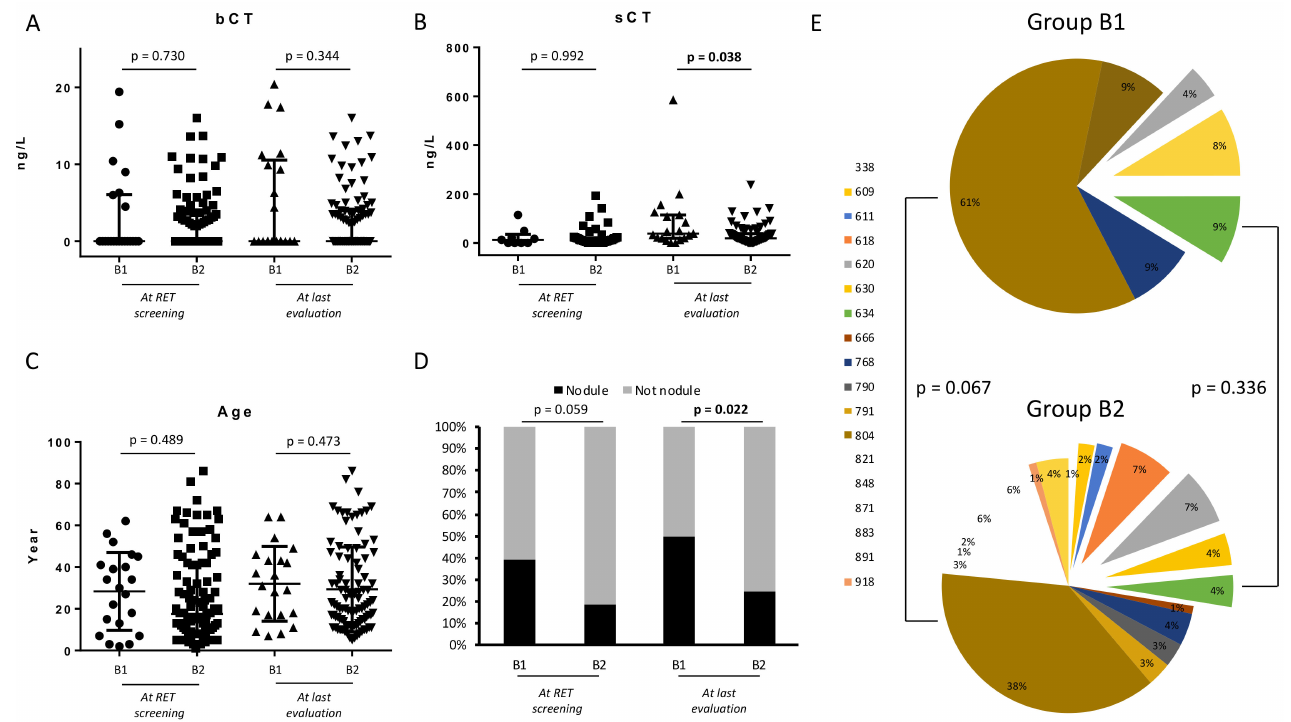
Figure 2. ( A , B ) basal CT (bCT) and stimulated CT (sCT) in Group B1 and B2 at RET screening and at last evaluation. ( C ) Age of subjects of Group B1 and Group B2 at RET screening and at last evaluation. ( D ) Rate of nodule at neck ultrasound in subjects of Group B1 and Group B2 at RET screening and at last evaluation. ( E ) Genetic landscape of subjects of Group B1 and Group B2.